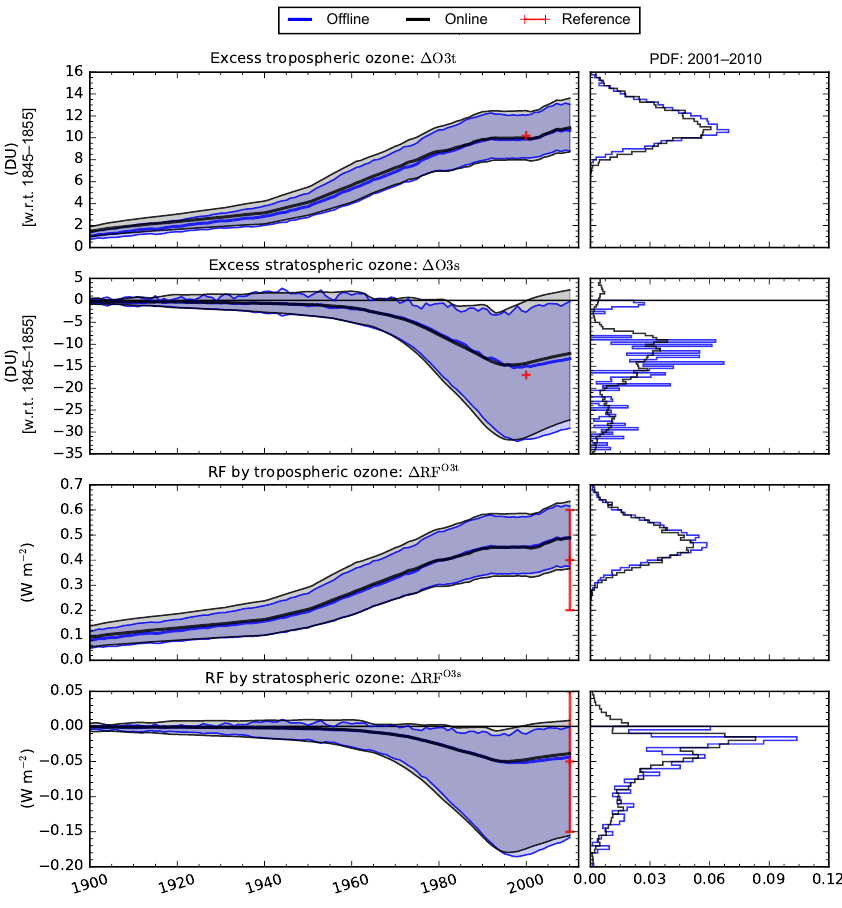
Figure 9. Results of our simulations with OSCAR, for ozone, with the same format as for carbon dioxide. Reference for the global burden is IPCC (2013) and for the radiative forcing and its 90% uncertainty range it is IPCC (Myhre et al.,